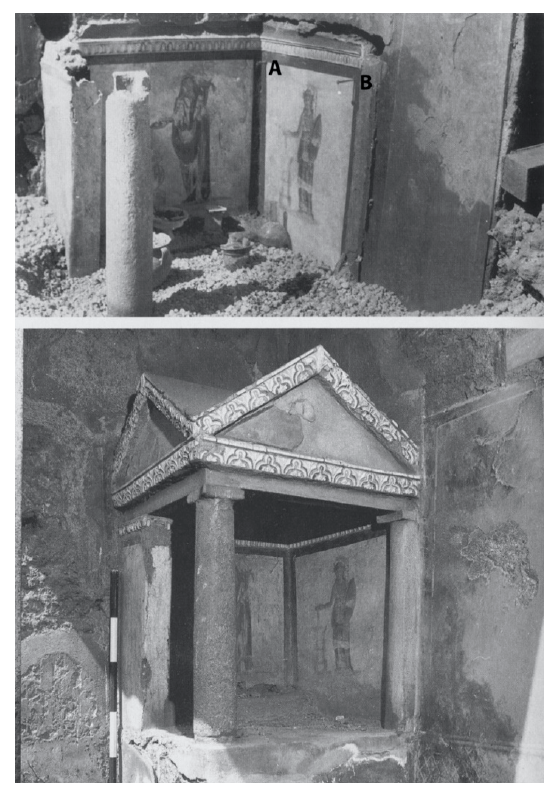
Figure 14. House 1.16.3, Pompeii. Atrium with sacellum . Above, an excavation photograph with nails above Minerva, indicated by letters ( A , B ). Below, a recent photograph with nails removed. (Modified by author, after PPM 2.988).